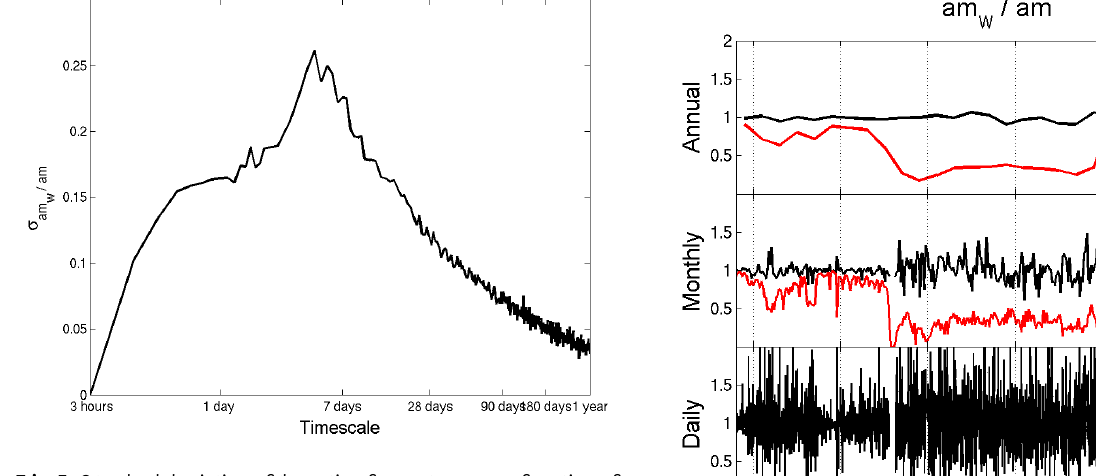
Figure 5. Fig. 5. Standard deviation of the ratio of am w to am as a function of averaging timescale between 3 hours and 1 year. Periods for which there is no am w value are discarded before computing the standard deviation.